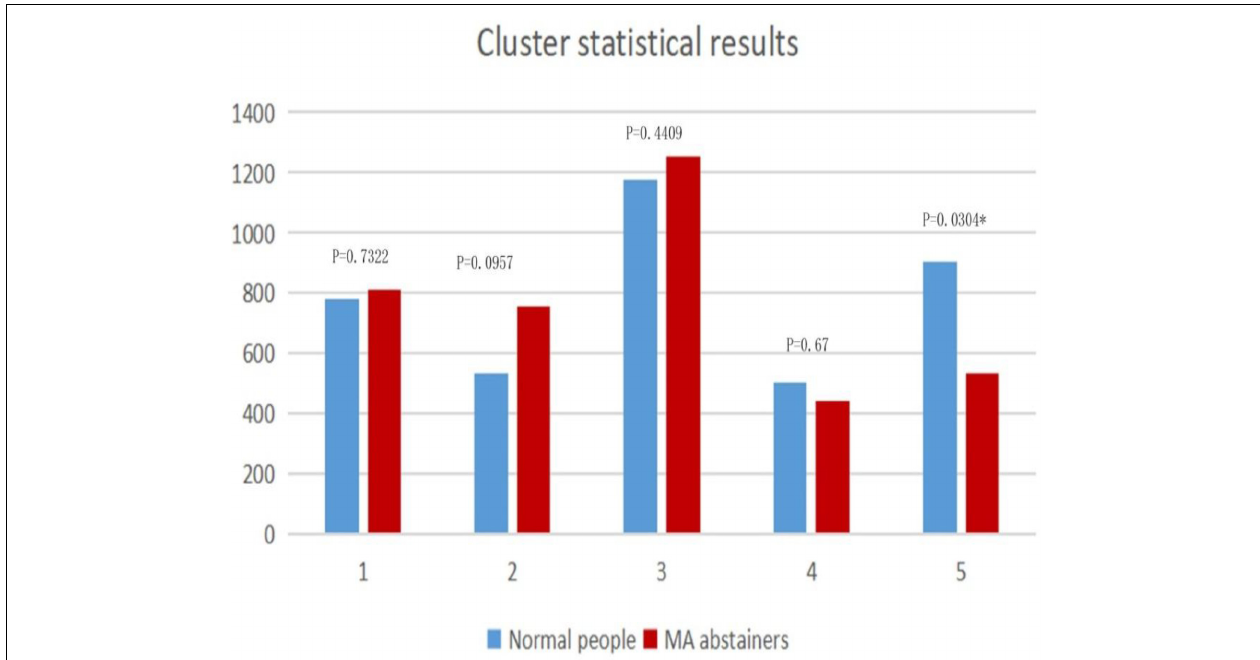
FIGURE 4 | The figure shows the distributions in clusters. The horizontal axis represents the state of each cluster, and the vertical axis is the total number of windows in each category. The p -value of the two-sample t -test for each state is marked on the histogram.